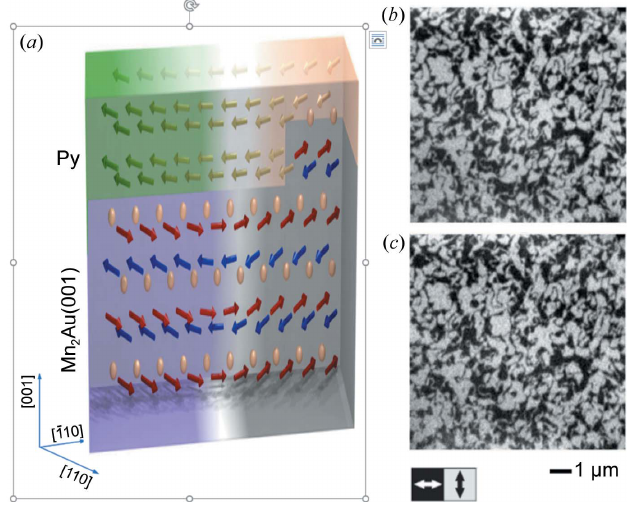
Figure 13 Schematic of an antiferromagnetic spintronics system of Mn 2 Au and Permalloy. The resemblance of the ferromagnetic and antiferromagnetic domain patterns is verified by XMLD images taken at the ( b ) Fe-edge and ( c ) Mn-edge, respectively. The antiferromagnetic domains of the Mn 2 Au layer can be read out by the Permalloy overlayer with strong exchange coupling between the two